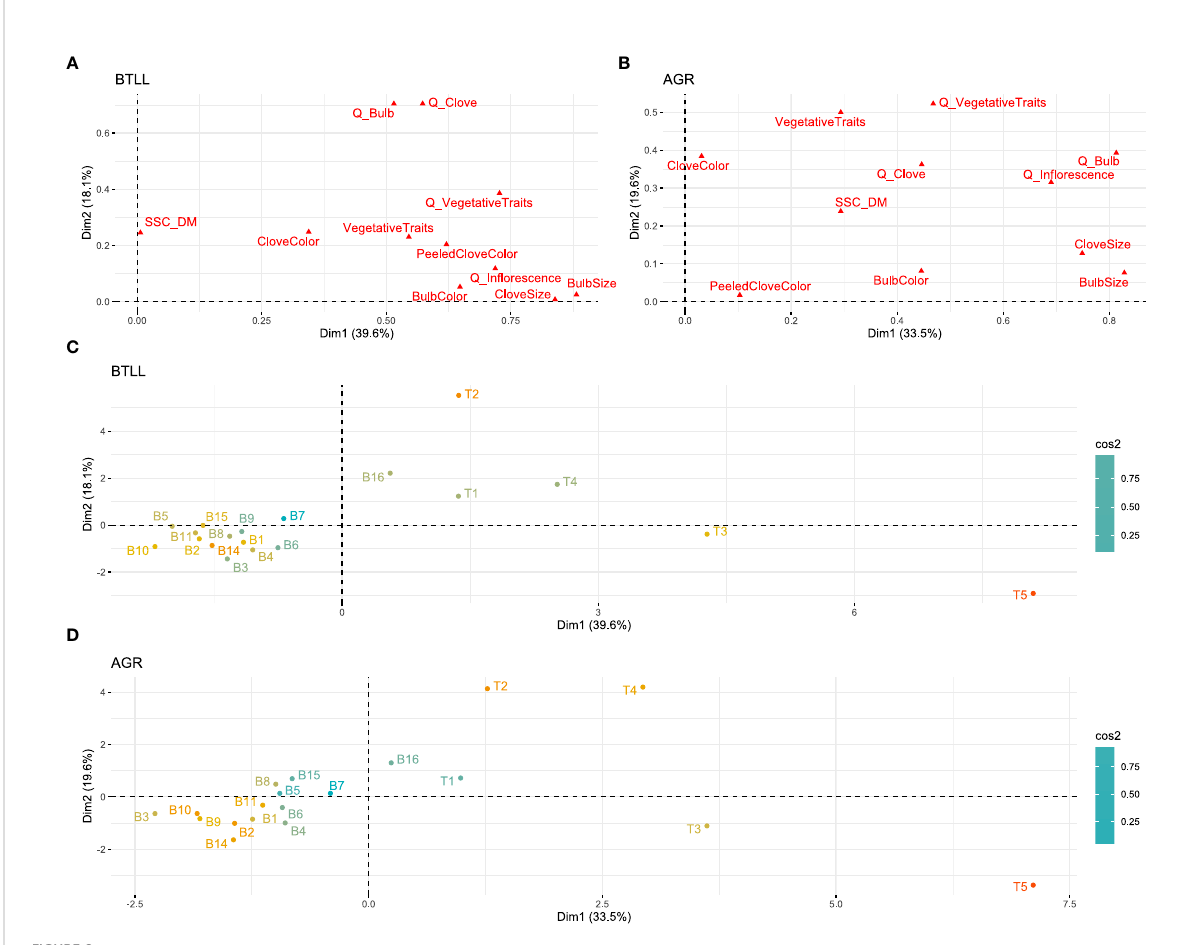
FIGURE 8 Multiplefactorialanalysis(MFA)ofqualitativeandquantitativetraits.Dim1-Dim2scatterplotsperformedonallthetraitsmeasuredinthelocalitiesofBelltall(BTLL, panels A,C ),andAgropolis(AGR,panels B,D ).Traitsaregroupedbytype(qualitativevariablesareprecededby “ Q_ ” )andcategories(vegetative,in fl orescence, bulb, clove, chemical composition(SSC_DM), and color (of the bulb, clove and peeled clove)). A and B, contributions of groups oftraits to the different dimensions; (C, D) positions of the accessions in the Dim1-Dim2 scatterplot. B1-B16, Belltalltraditional accessions; T1-T5,controls. Dim,